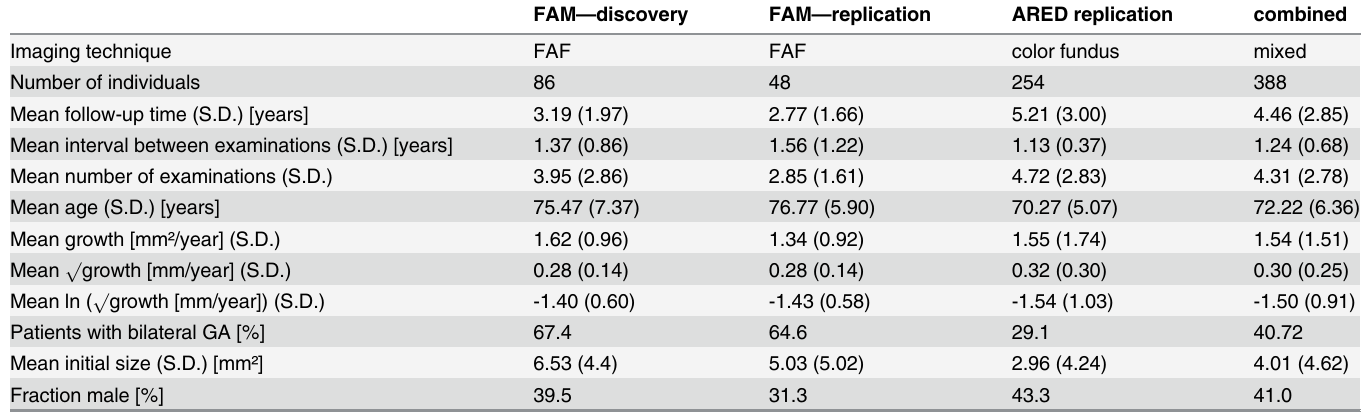
Table 1. Summary characteristics of participating study